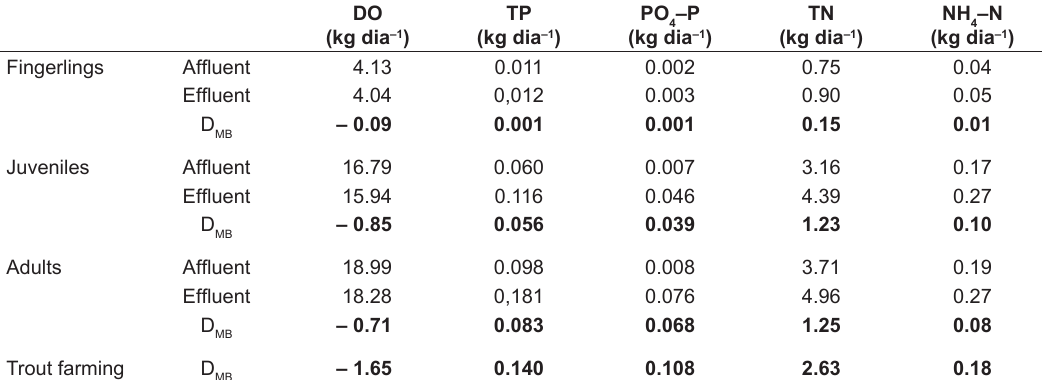
Table 3. Daily mass balance (D ) (mean values) of dissolved oxygen (DO), total phosphorus (TP), orthophosphate MB (PO -P), total nitrogen (TN) and ammonium (NH -N) in the sectors of the trout farming system. In the last line 4 4 is the mean value of the daily mass balance (D ) of the trout faming MB